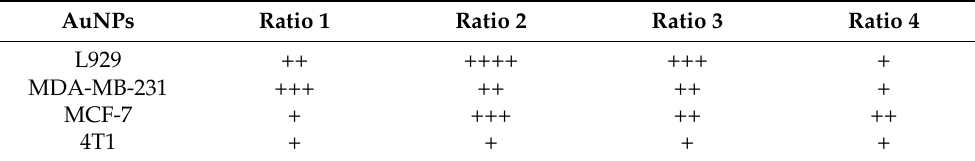
Table 4. Score of AuNPs internalization per cell line by brightfield optical microscopy. AuNPs